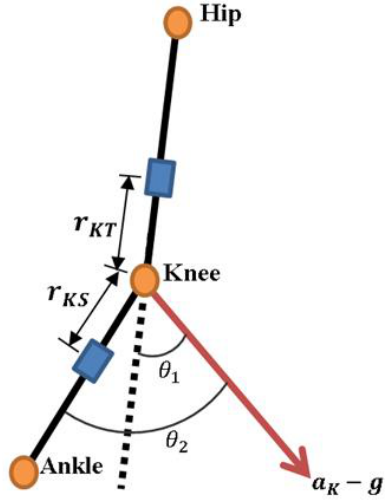
Figure 3. θ 1 is the inclined angle of a K − g in relation to thigh segment and θ 2 the inclined angle of a K − g in relation to shank segment.